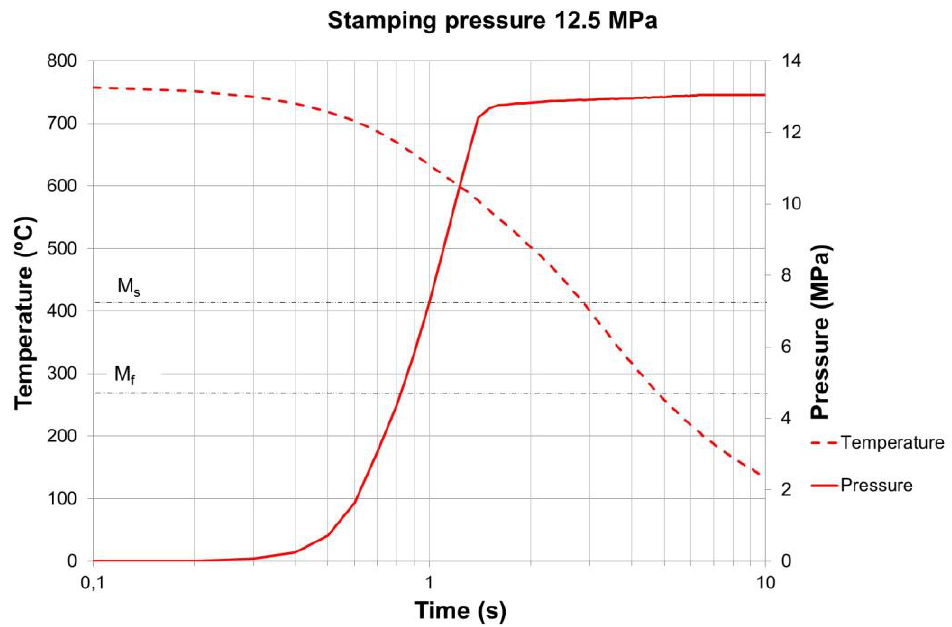
Figure 9. Temperature–pressure–time plot for a pressure set-point of 12.5 MPa.